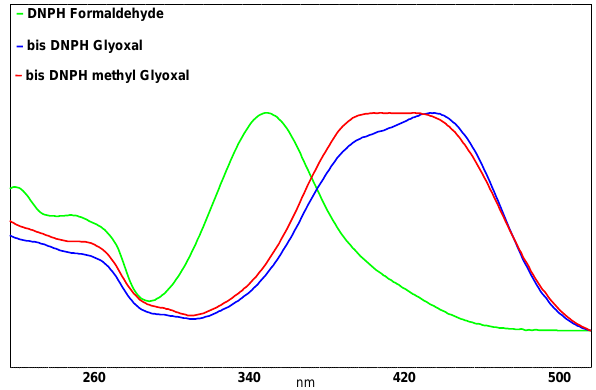
Figure 2. Absorption spectra for monocarbonyl formaldehyde (green), dicarbonyls glyoxal (blue line) and methylglyoxal (red line).